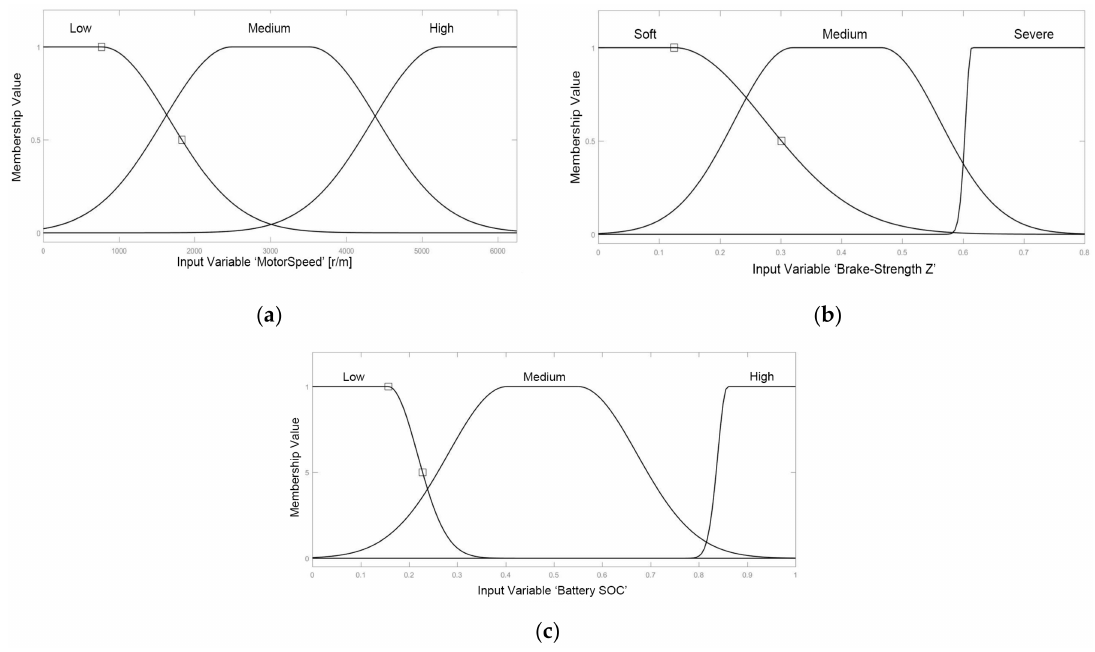
Figure 13. ( a ) Membership function of the motor speed. ( b ) Membership function of the brake strength ( z ). ( c ) Membership function of the battery